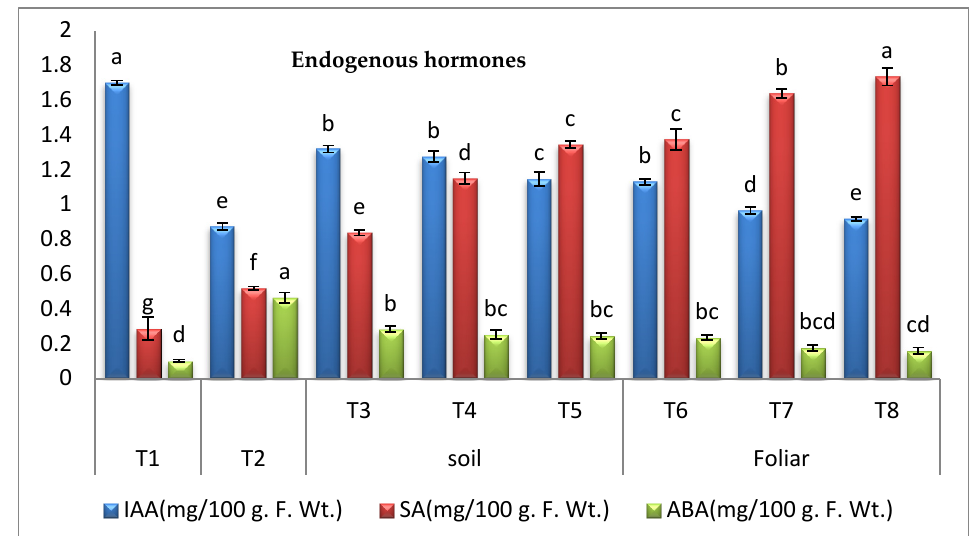
Figure 8. Effect of cyanobacteria on endogenous hormones (IAA, SA, and ABA) of infected pepper plants (T1-healthy control, T2-infected control, T3-infected plants treated with D. muscorum soil, T4- infected plants treated with A. oryzae soil, T5-infected plants treated with A. platensis soil, T6-infected plants treated with D. muscorum foliar spray, T7-infected plants treated with A. oryzae foliar spray and T8-infected plants treated with A. platensis foliar application.) (Data represent mean ± SD, n = 3), (a–f Letters revered to significant in statically analysis).